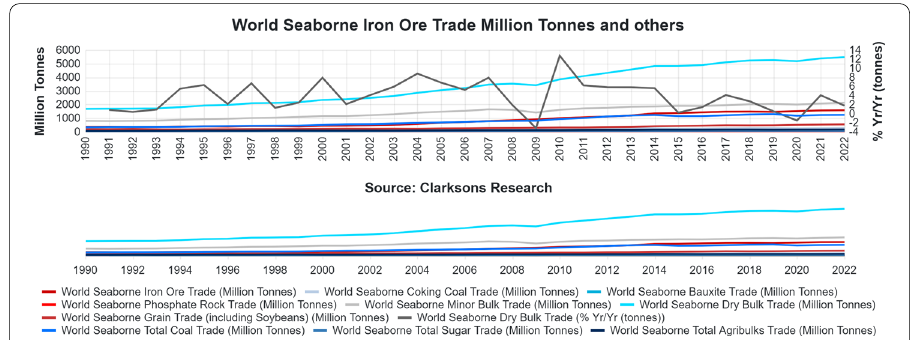
Fig. 1 World seaborne dry bulk trade growth. Source : Clarksons Research Intelligence